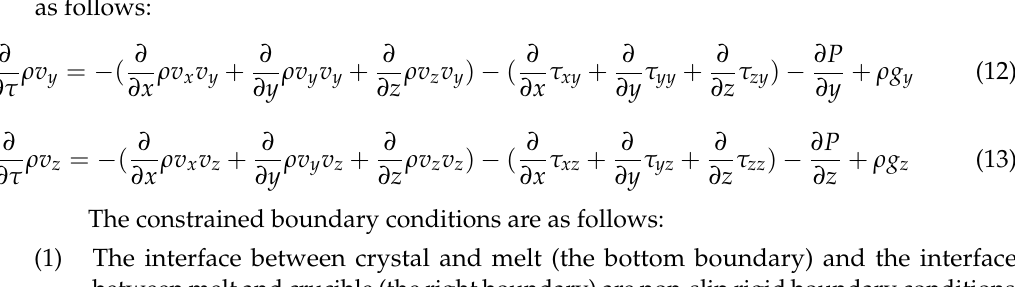
The interface between crystal and melt (the bottom boundary) and the interface between melt and crucible (the right boundary) are non-slip rigid boundary